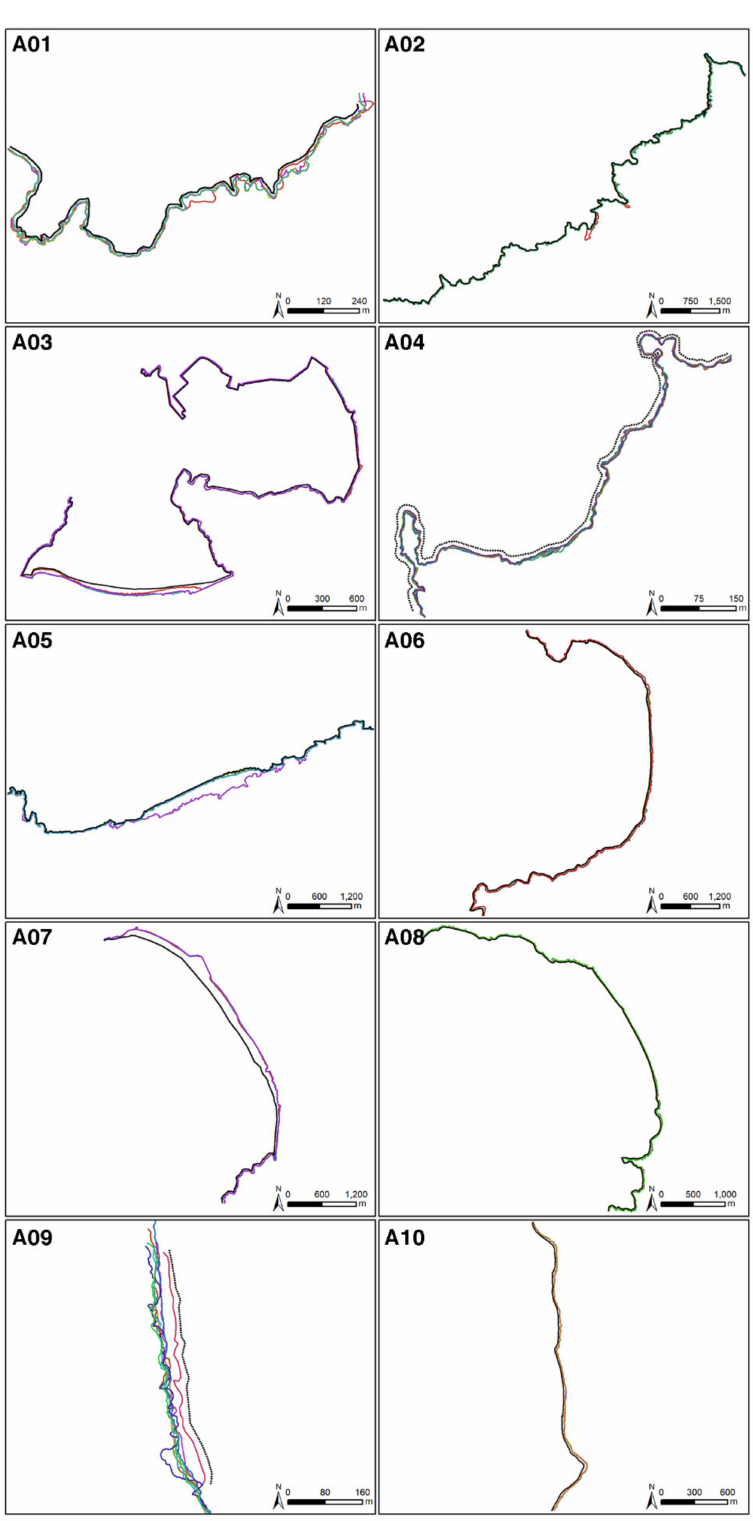
Figure A1. Baseline position in black points and shorelines in colored scale on each study